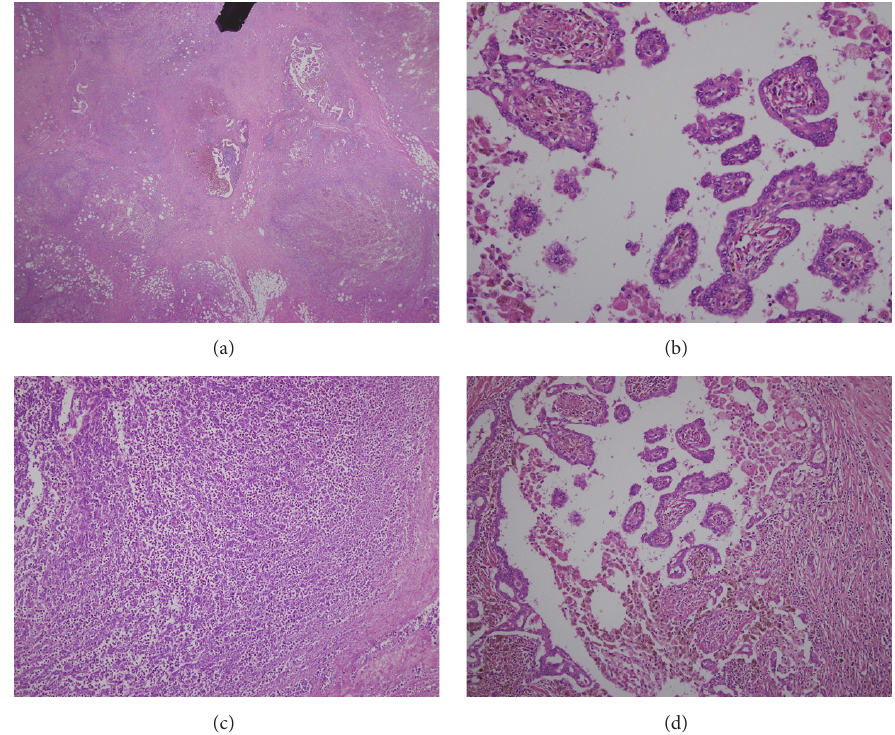
Figure 4: (a) Panoramic view of the resected node which contains the papillary carcinoma and necrotic debris (H&E stain, × 25). (b) Histological characteristics of the papillary cancer (H&E stain, × 200). (c) Histological characteristics of the abscess (H&E stain, × 100). (d) Histological characteristics of the papillary cancer (H&E stain, ×